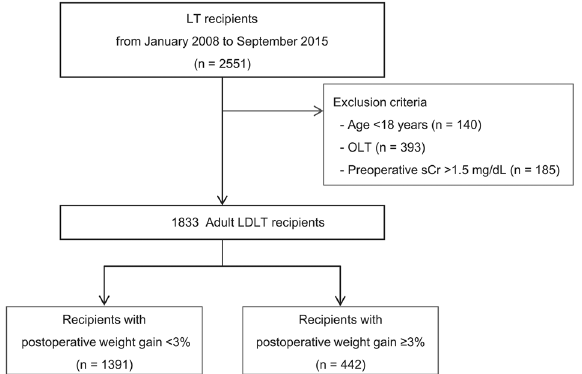
Figure 1. Flowchart of the study population. Abbreviations: LT, liver transplantation; OLT, orthotopic liver transplantation; sCr, serum creatinine; LDLT, living donor liver